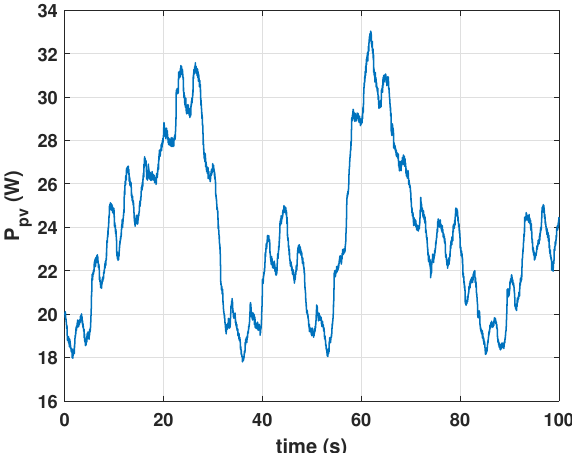
Figure 19. Output power of the PV